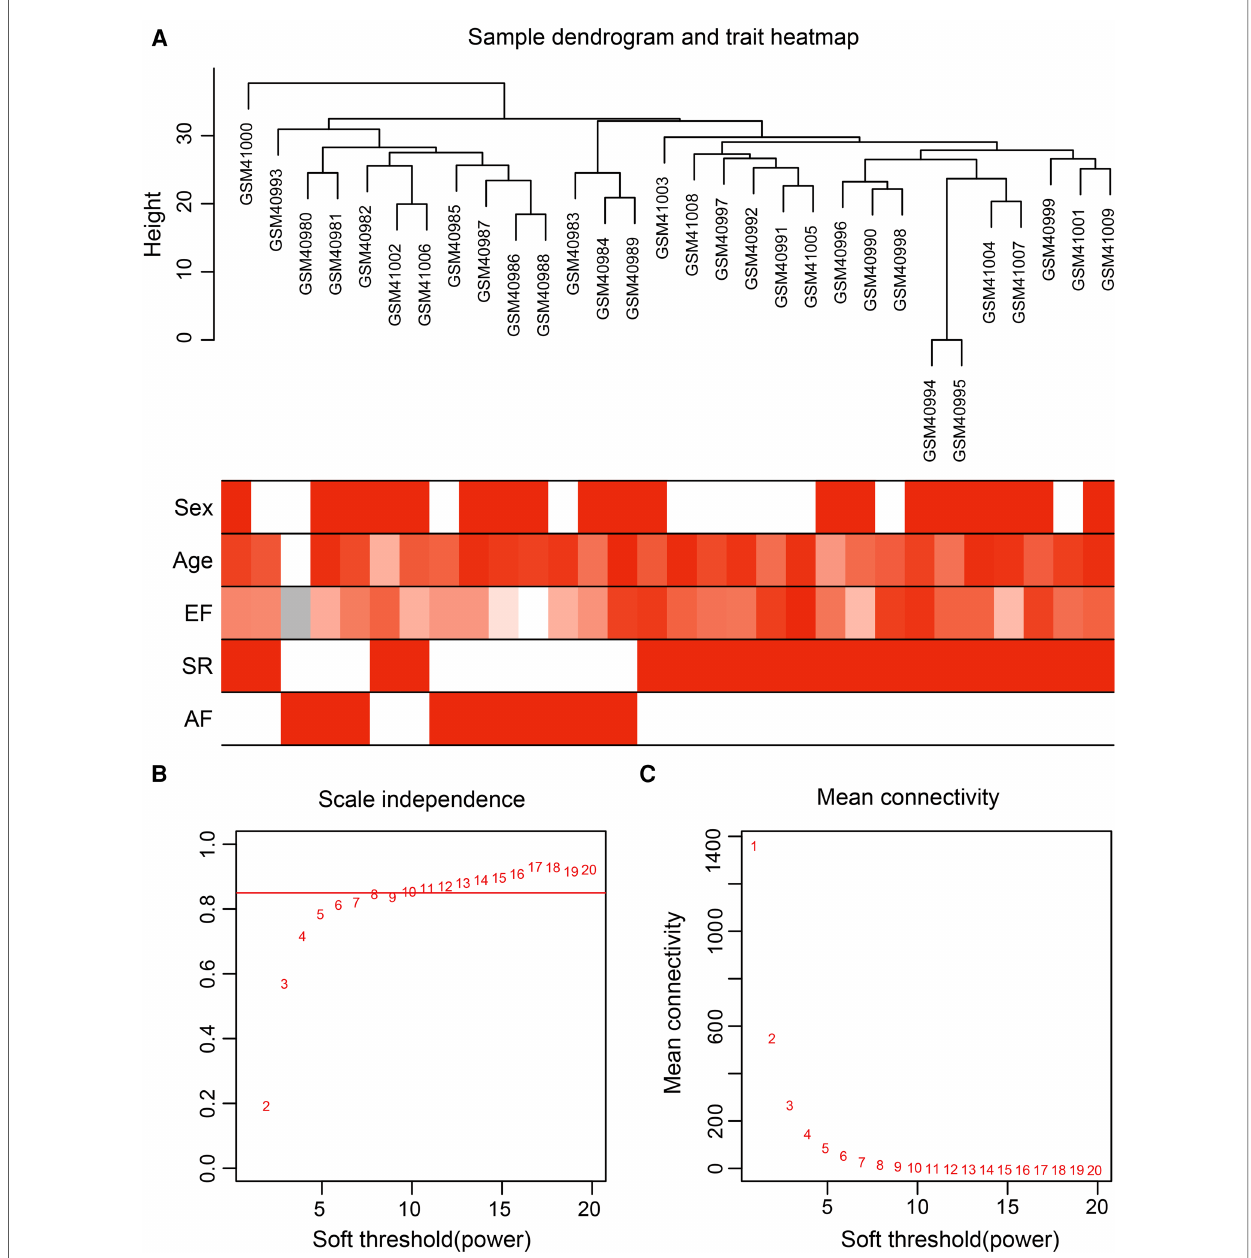
FIGURE 2 Data preparation of co-expression network. ( A ) Clinical feature heatmap and hierarchical clustering dendrogram. The degree of heatmap from white to dark red recognizes low to high levels of clinical characteristics, and gray indicates unavailable data. The clinical feature includes sex, age, ejection fraction (EF), SR and AF. ( B,C ) A scale-free co-expression network estimated by the soft-thresholding powers, and the best power value β was obtained as